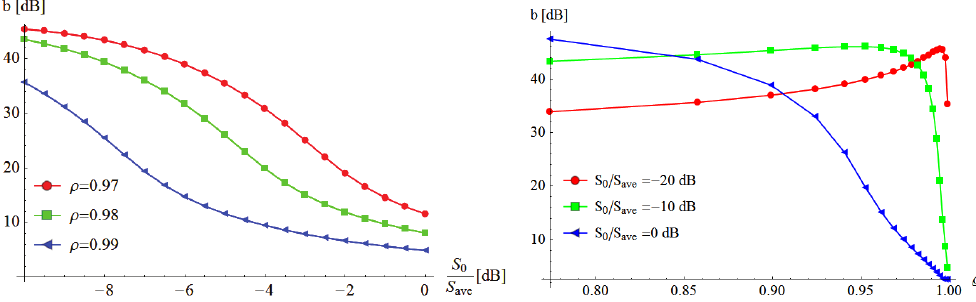
Figure 2. Backoff required for URC link adaptation against wanted signal variation. Left: Backoff vs. S 0 / S ave for three different ρ values; Right: Backoff vs. ρ for three different S 0 / S ave